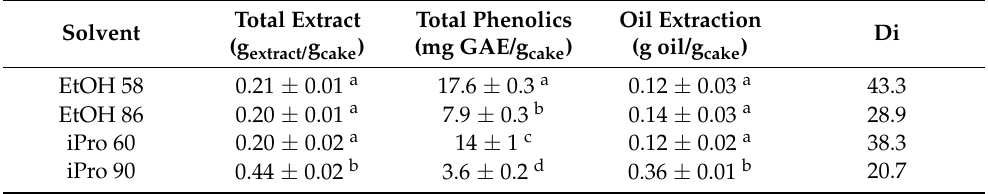
abcd Values with different superscript letters within a column are significantly different at p <